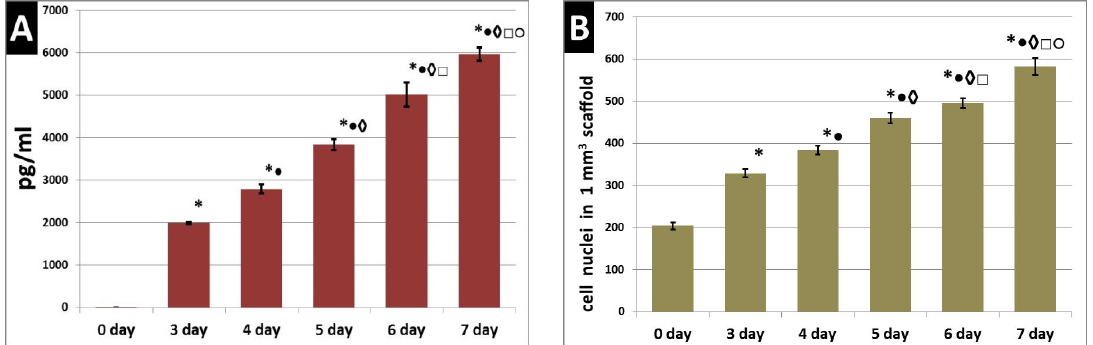
Figure 3. Functional and proliferative activity of ASCs cultured in scaffolds. ( A ) Secretion of VEGF-A by ASCs cultured in scaffolds; ( B ) number of cell nuclei in the per 1 mm 3 scaffold. Note: *— p ˂ 0.05 comparison with day zero, •—comparison with day three, ◊ —comparison with day four, □ — comparison with day five, ○ —comparison with day six, Wilcoxon